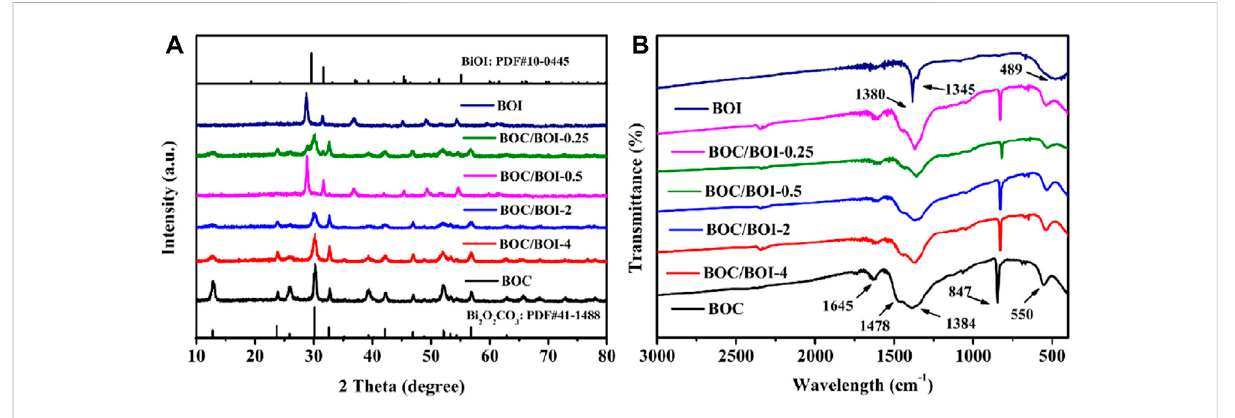
FIGURE 1 (A) XRD patterns, (B) FT-IR spectra of all